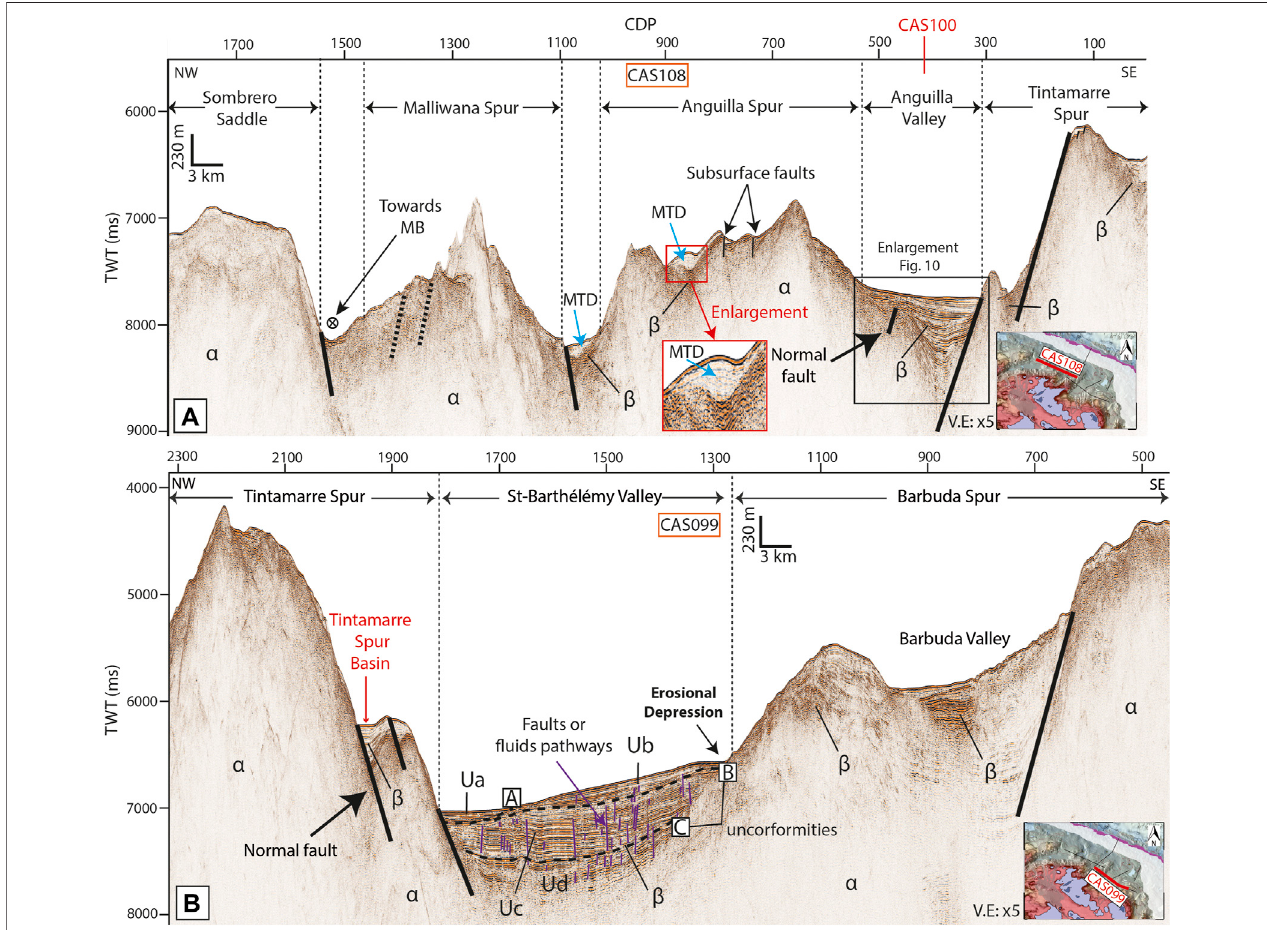
FIGURE 7 | Seismic pro fi les: (A) CAS108, uncertain faults are in dashed black. A, B, and C are unconformities, Ua to Ud are different seismic units. The black box locates an enlargement reporting to Figure 10 ; (B) CAS099. Acoustic facies in the seismic pro fi les [ α ] chaotic unit (acoustic basement) and [ β ] unit with evidence of numerousandstrati fi edre fl ectors(basins,valleys).Redlinesintheinsertmapsindicatethepositionoftheseismicpro fi les.Theverticalexaggeration(V.E)isx5forthetwo seismic pro fi